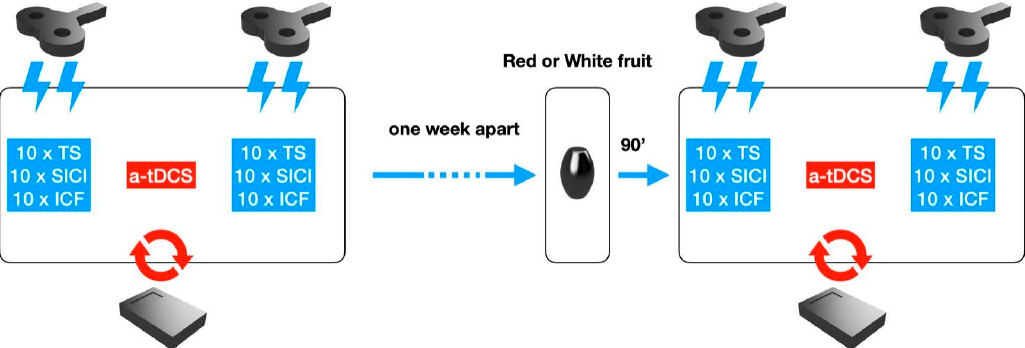
Figure 1. Schematic procedure of the NIBS and NIN sessions. TMS stimulation in baseline conditions was performed before and after a-tDCS to record values of Test stimulus (TS), Short Intracortical Inhibition (SICI), and Intracortical Facilitation (ICF) in random order. Next, one week apart, TMS and a-tDCS stimulations were performed 90 min after red or green fruits ingestion.